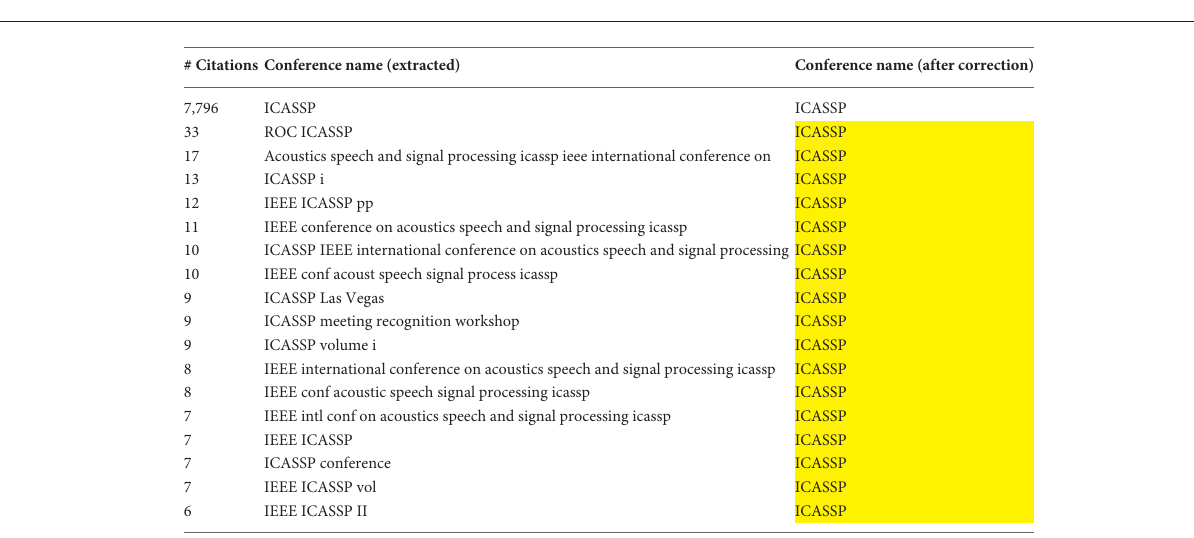
FIGURE 10 | Example of cleaning cited conferences: the case of IEEE ICASSP.